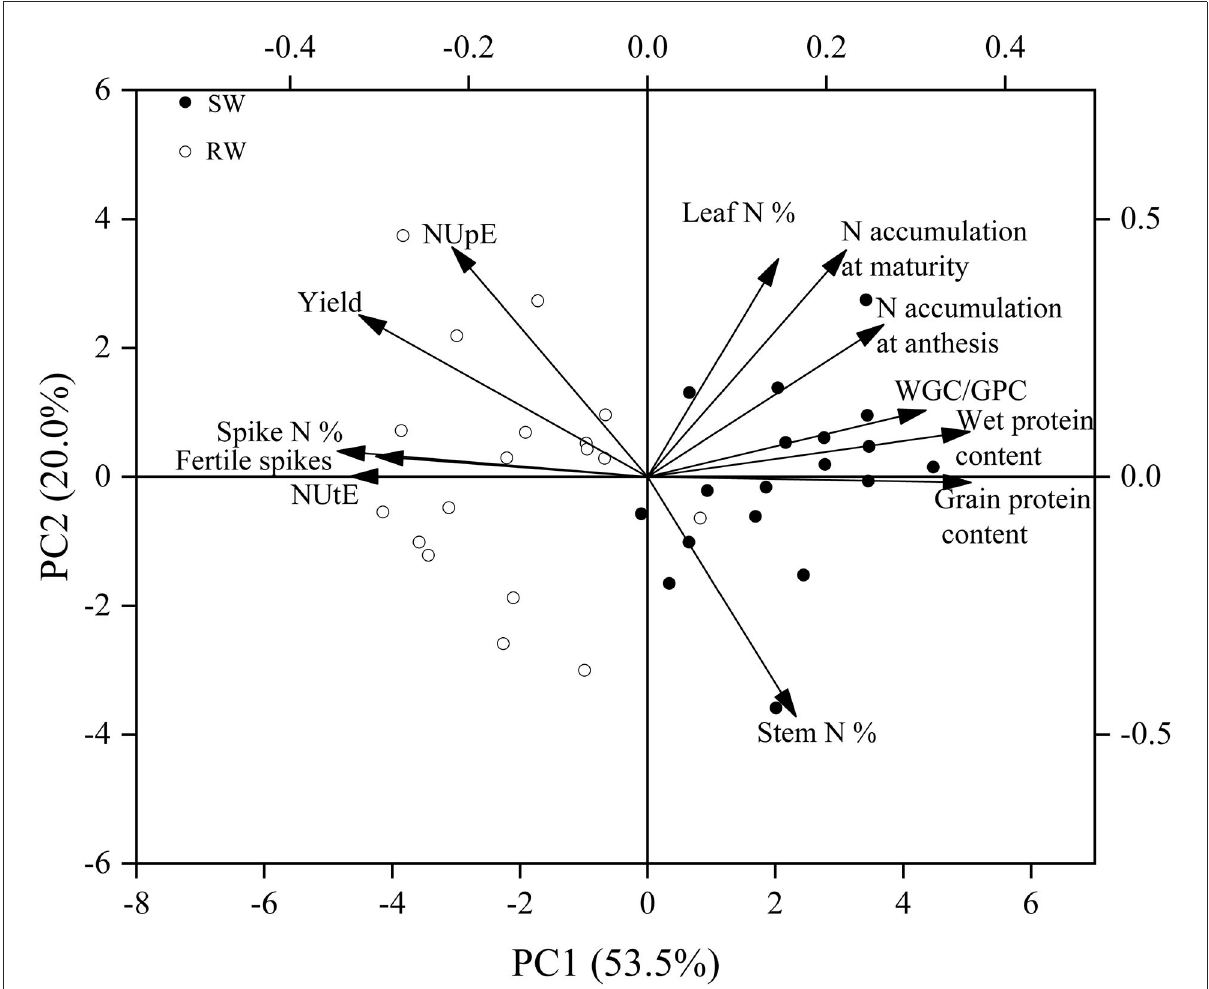
FIGURE2 The principal component analysis (PCA) on yield, grain protein quality, and nitrogen efficiency and related traits in two wheat cropping systems and two cropping years. All values were measured with three replications ( n = 3), and the two-year data were pooled. SW, soybean-wheat cropping system; RW, rice-wheat cropping system; WGC/GPC, Wet gluten content/grain protein content; N, nitrogen; NUpE, N uptake efficiency; NUtE, N utilization efficiency.